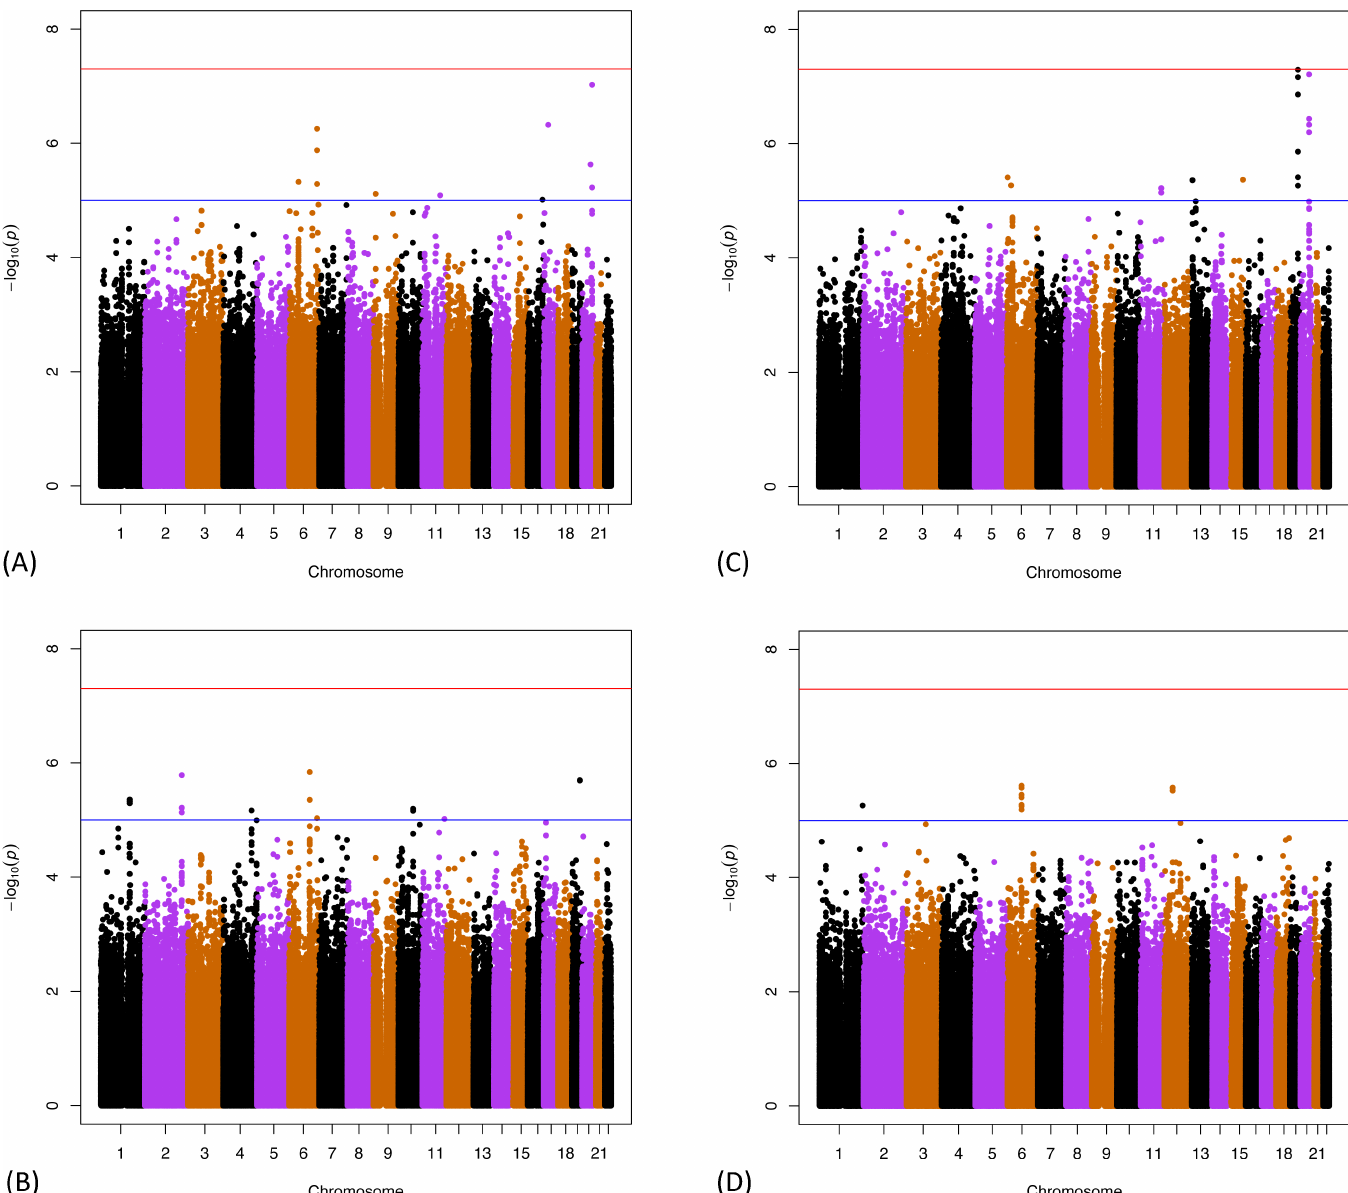
Fig 2. P-values for all 1,198,956SNP associations from GWAS on the HRS genetic sample. (A) Level of Immediate Recall (IR-L); (B) Changein Immediate Recall (IR-C); (C) Level of ResidualizedDelayedRecall (rDR-L); (D) Changein ResidualizedDelayedRecall (rDR-C). For these figures, the upper (red) horizontal line demarcates the threshold of p = -log(5.0x10 -08 ) and the lower (blue) horizontal line demarcates p = -log(1x10 -05 ). SNPs are arrangedby their chromosomal position(x-axis). One SNP on chromosome 20, rs6125934 ( b = -0.030, p = 6.0x10 -08 ) approached the genome-wide cutoff for an association with rDR-L in HRS but that effect size did not replicate in ELSA ( b = 0.004, p = 6.0x10 -01 ). Similarly, a SNP on chromosome 20, rs6025261 ( b = 0.079, p = 9.0x10 -08 ) exceeded the suggestive level for an association with IR-L, but the effects did not replicate in ELSA ( b = 0.008, p = 5.0x10 -01 ). Several other SNPs met the criterion for suggestive association with IR-C (7 SNPs) or rDR-C (6 SNPs), but effects did not replicate in ELSA.